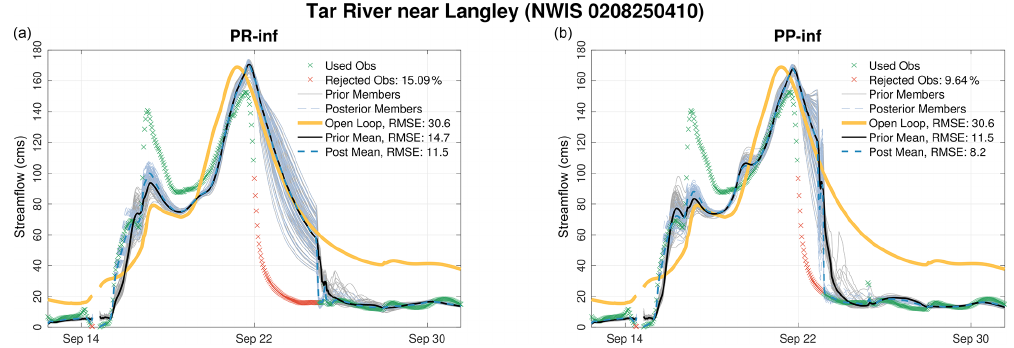
Figure 9. Similar to Fig. 7 but for Tar River near Langley. Only the PR-inf (a) and PP-inf (b) results are shown. In addition to the ensemble means, the prior and posterior members are also plotted. Discontinuities in the hydrograph means that there are no observations to